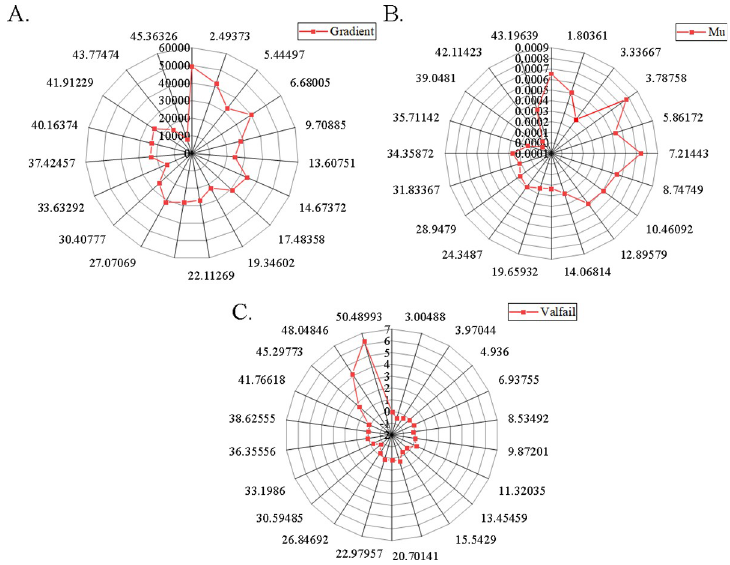
Fig 8. The training gradient size, error, and verification times. Fig A: the gradient size, Fig B: the error, Fig C: the number of verifications.